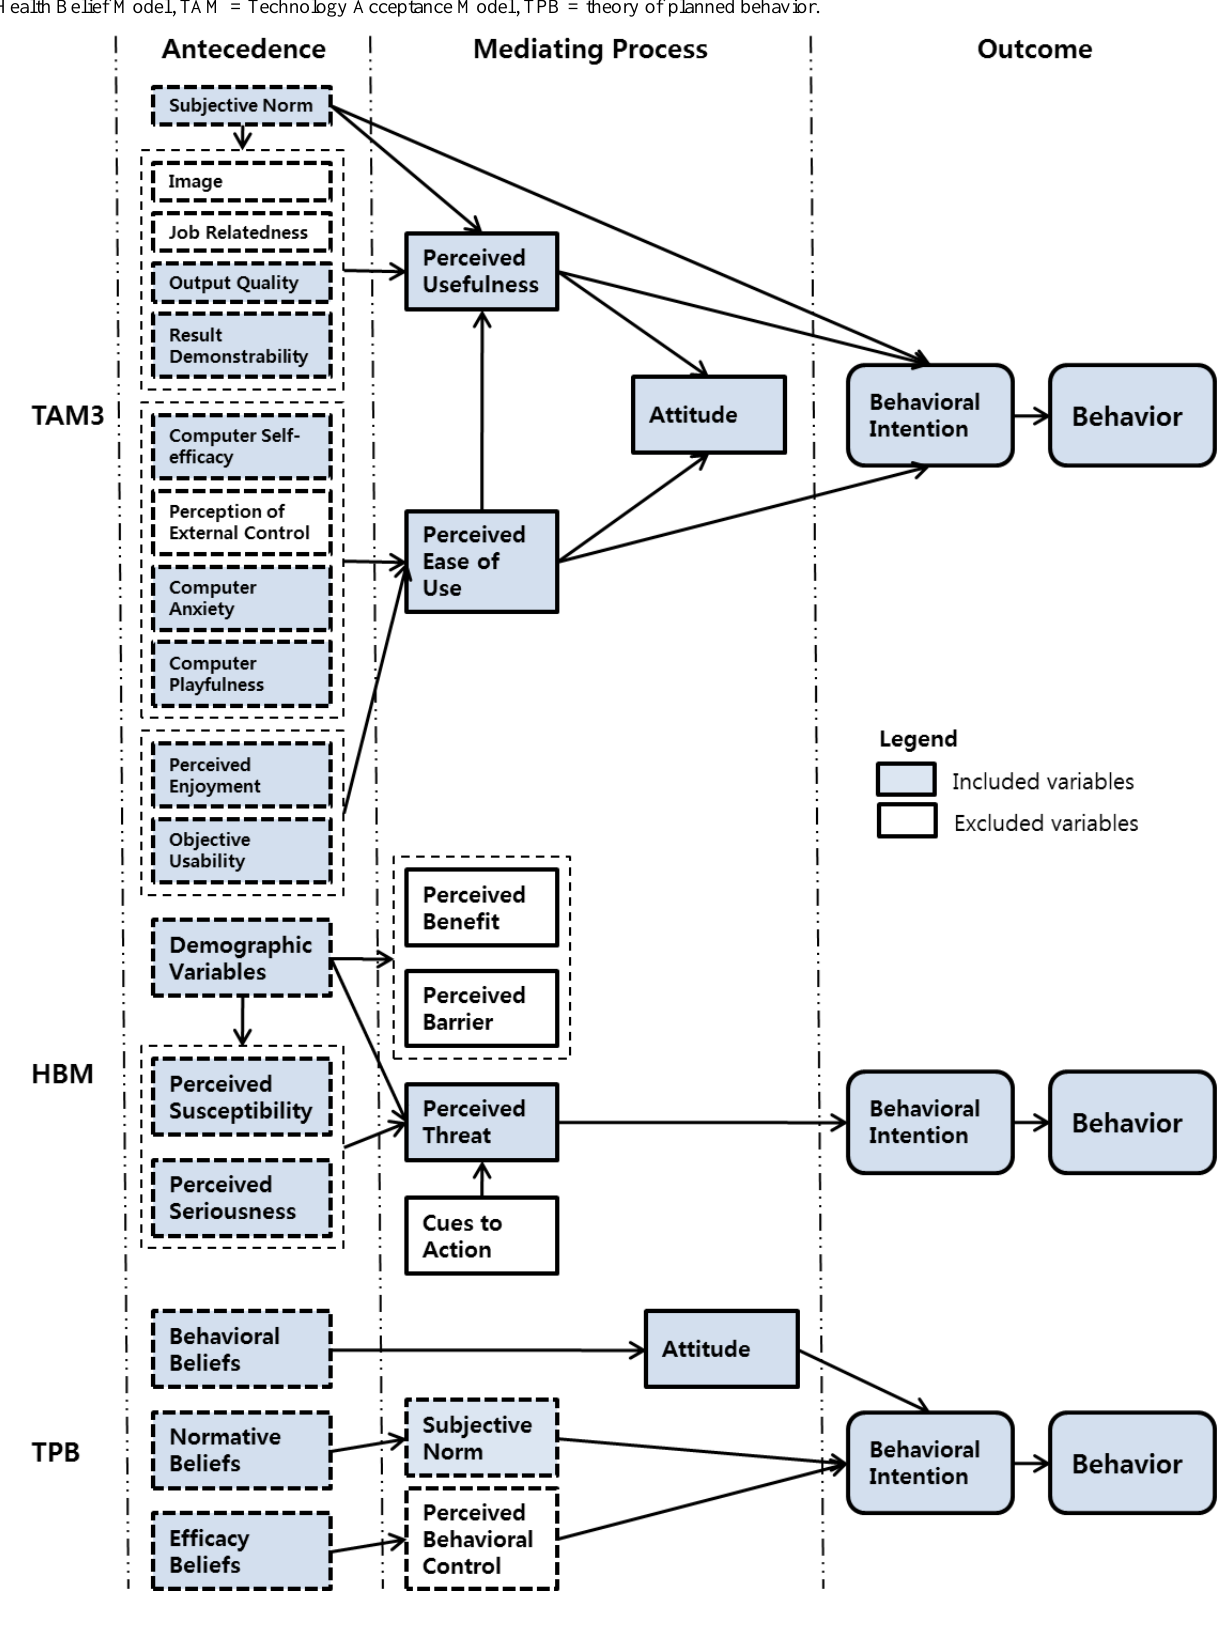
Figure 1. Conceptual relationships of the relevant models for development of the Health Information Technology Acceptance Model (HITAM). HBM = Health Belief Model, TAM = Technology Acceptance Model, TPB = theory of planned